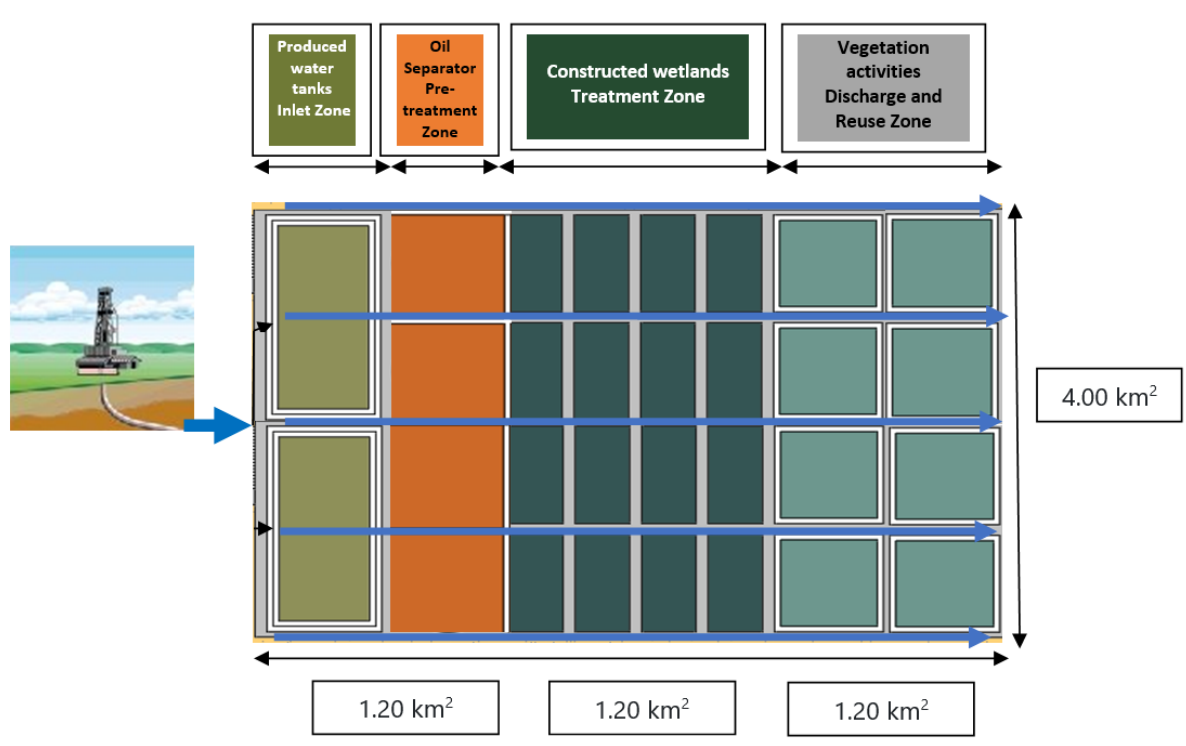
Figure 5. Constructed wetlands plan. Table 4. The estimated cost of the potential